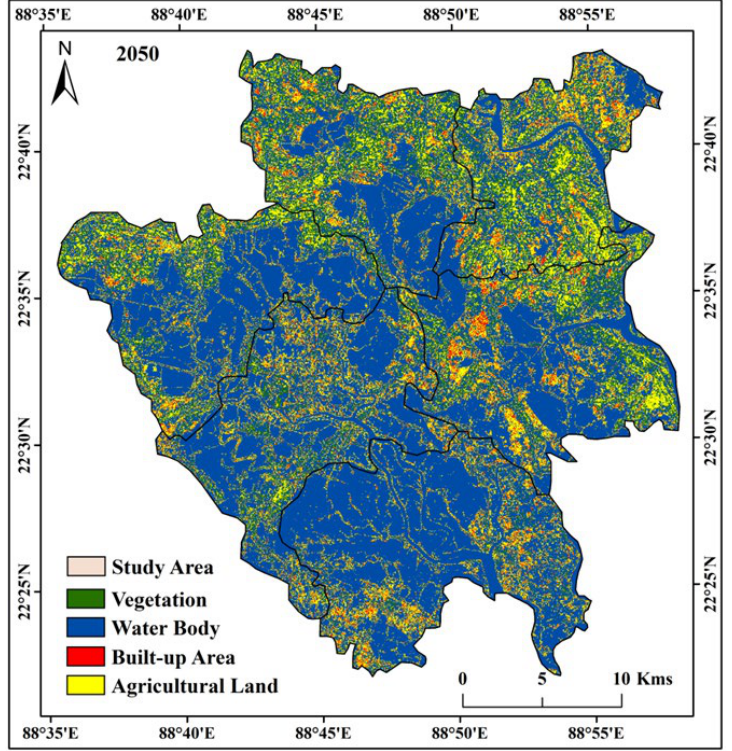
Figure 10. Prediction map of the study area in the year 2050.